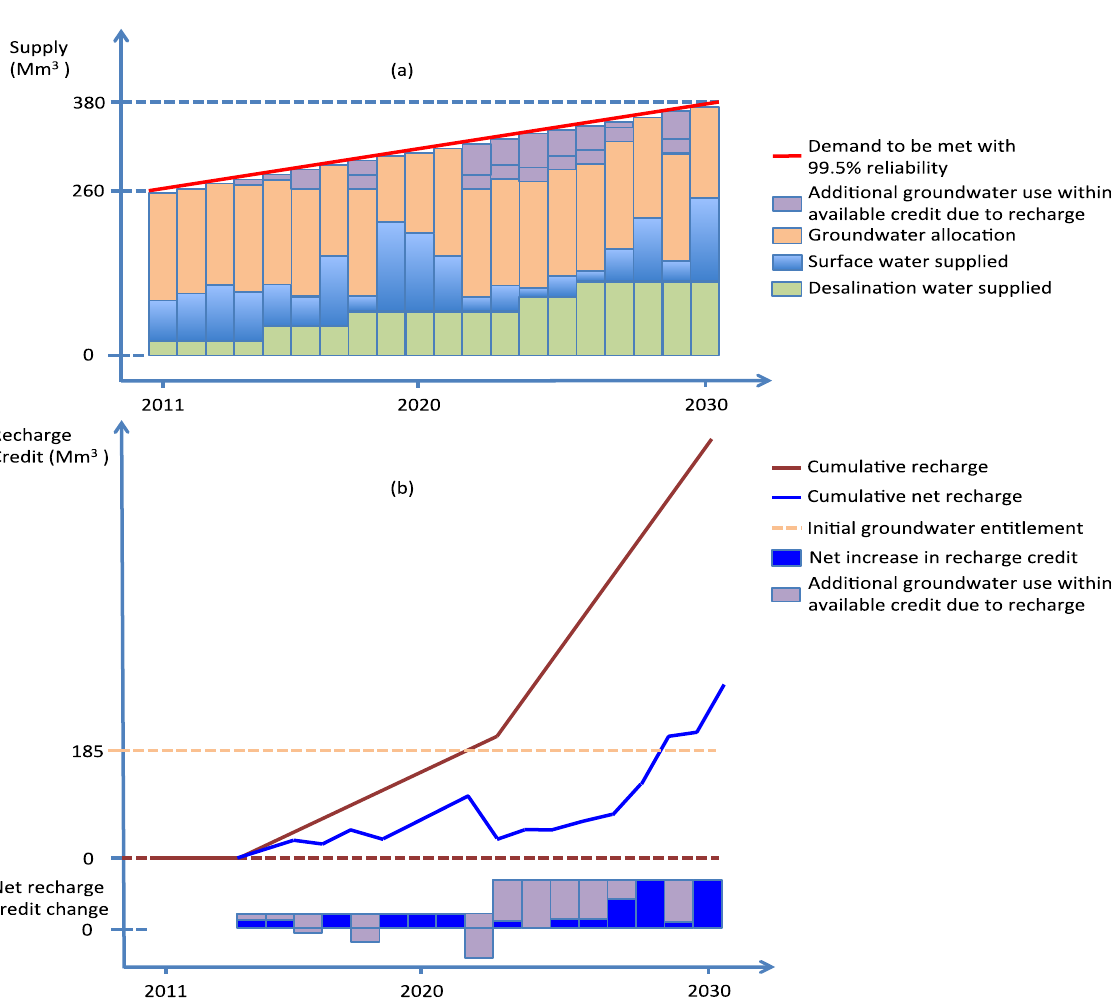
Figure 1. An example of a portfolio of water supply and corresponding recharge credit: ( a ) the varying water supply portfolio to meet demand each year (taken from one Monte Carlo simulation; and ( b ) recharge credit accumulates based on operation of the installed recharge capacity. The net recharge credit available for extraction is the difference between accumulated recharge allowing for depreciation (losses) and accumulated withdrawals to meet water supply